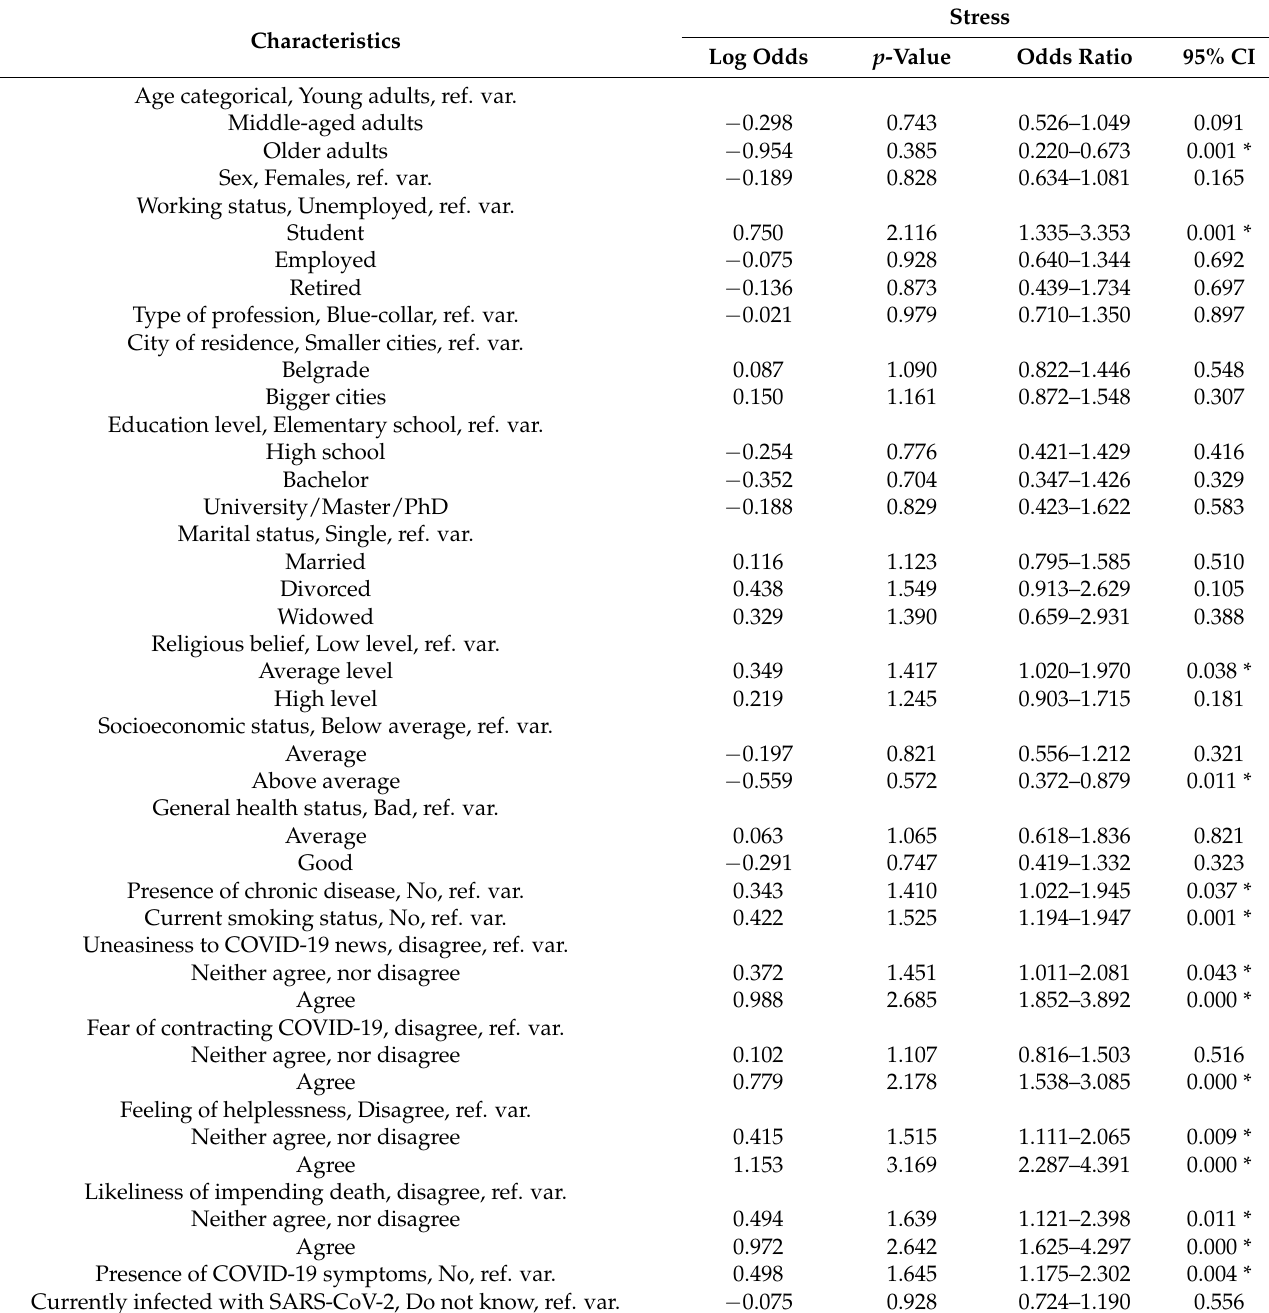
Table 6. Ordinal regression results for the stress